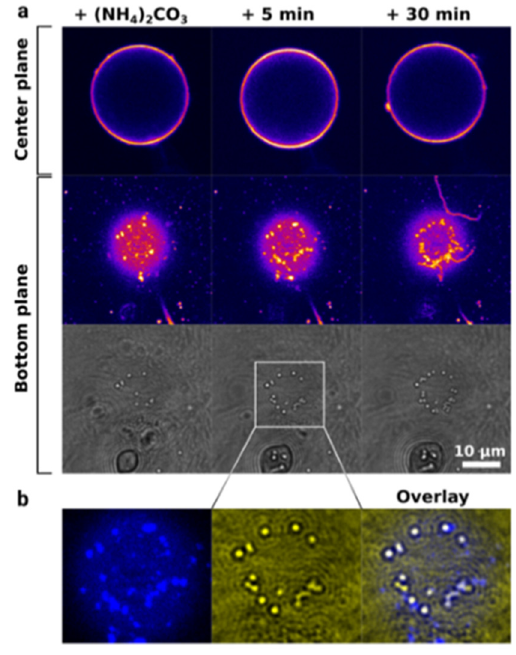
Figure 4. Crystallization of calcium carbonate within a vesicle: ( a ) CLSM images of a labeled vesicle at the central plane and bottom plane, and corresponding bright-field images at the bottom plane. ( b ) Magnified CLSM image of the labeled vesicle (left), bright-field images of CaCO 3 particles at the central place, and an overlay of the two images. White spots in the overlay correspond to the colocalization of CaCO 3 and the lipid membrane of the vesicle. Image reproduced from Hannes Witt et al., with permission from Langmuir [51].